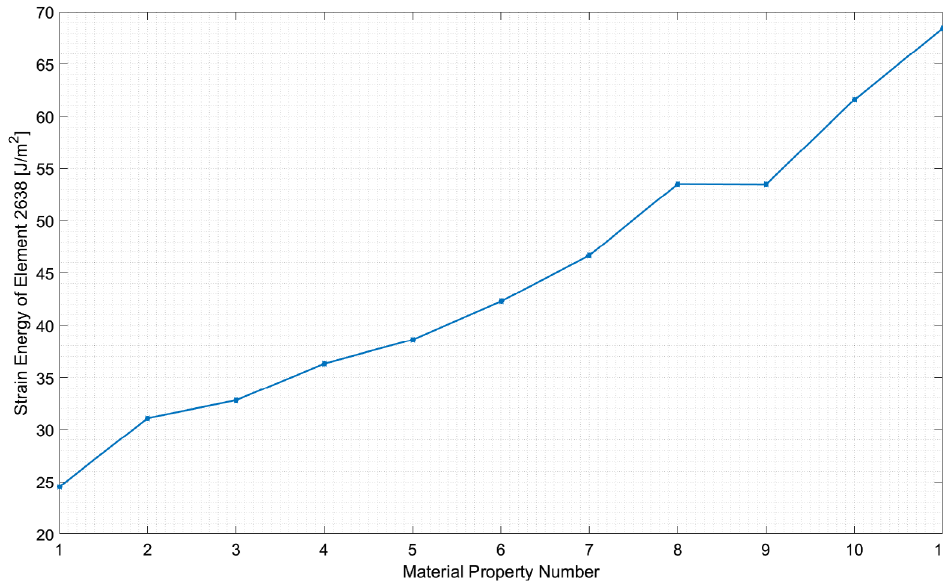
Fig. 4. Resulting strain energy in element number 2638.